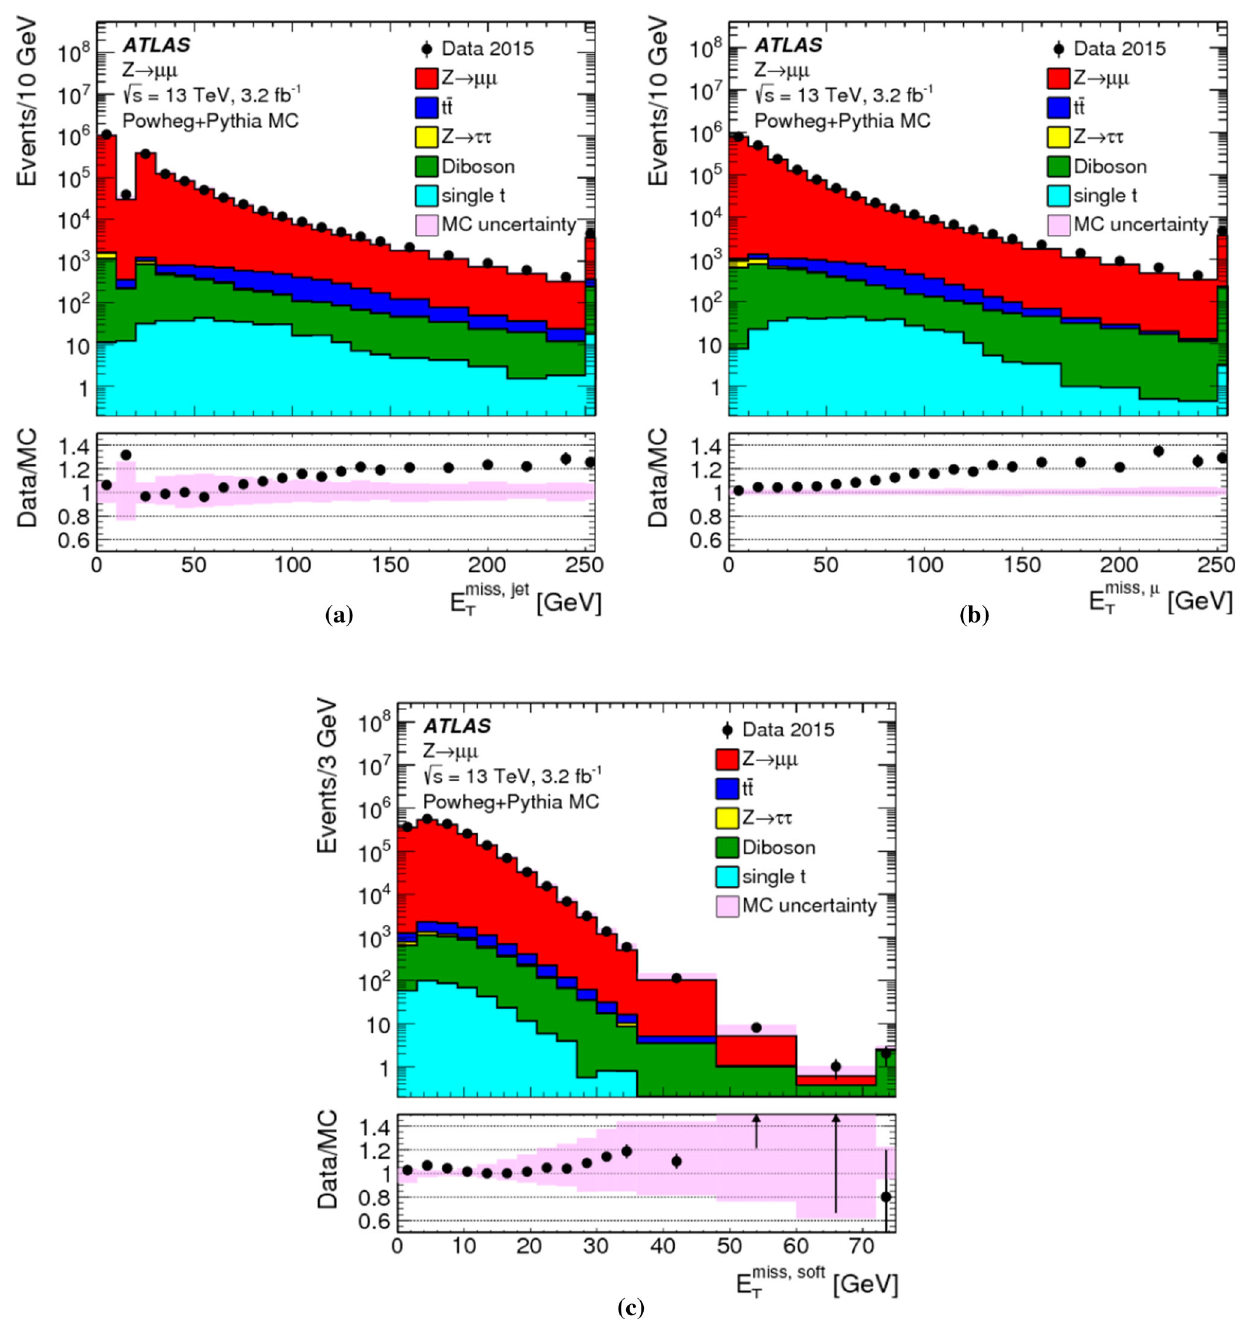
, jet ,μ Fig. 2 Distributionsof a thejetterm E miss respective systematic uncertainties from a the jet, b the muon, and c the , b themuonterm E miss , T T soft term. The last bin of each distribution includes the overflow entries. and c the soft term E miss , soft for the inclusive samples of Z → μμ T TherespectiveratiosbetweendataandMCsimulationsareshownbelow events in data, compared to MC simulations including all relevant back- the distributions, with the shaded areas showing the corresponding total grounds. The shaded areas indicate the total uncertainty from MC sim- uncertainties from MC simulations ulations, including the overall statistical uncertainty combined with the